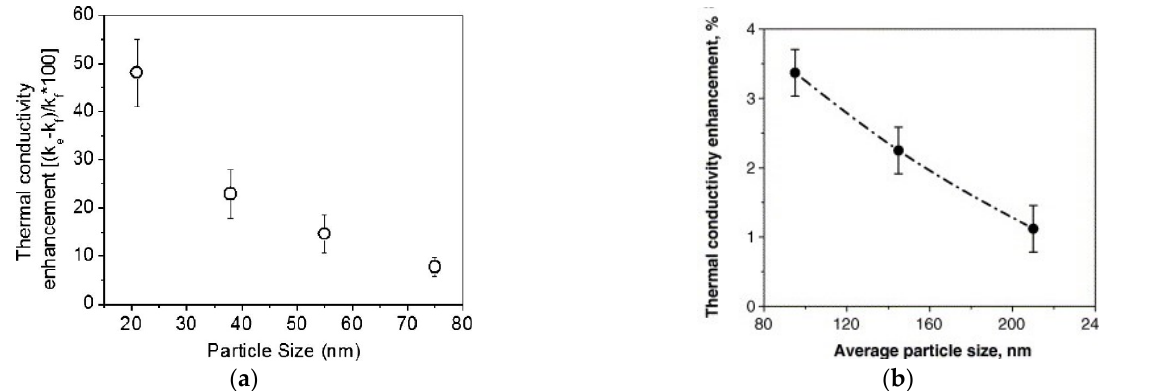
Figure 3. Thermal conductivity enhancement percentage of two different nanofluids as a function of particle size ( a ) [41] ( b ) [44].